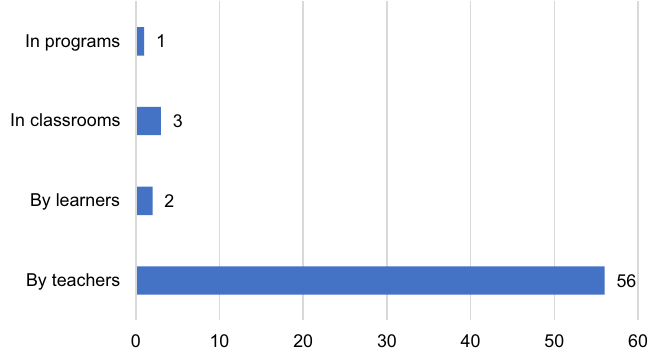
Fig. 9 Frequencies of approaches to textbook